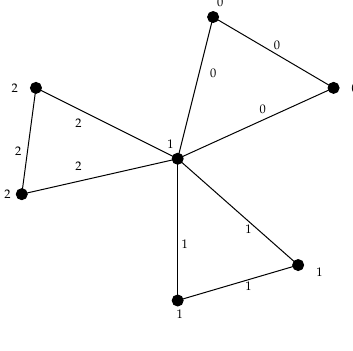
Figure 13. Fan graph F 6